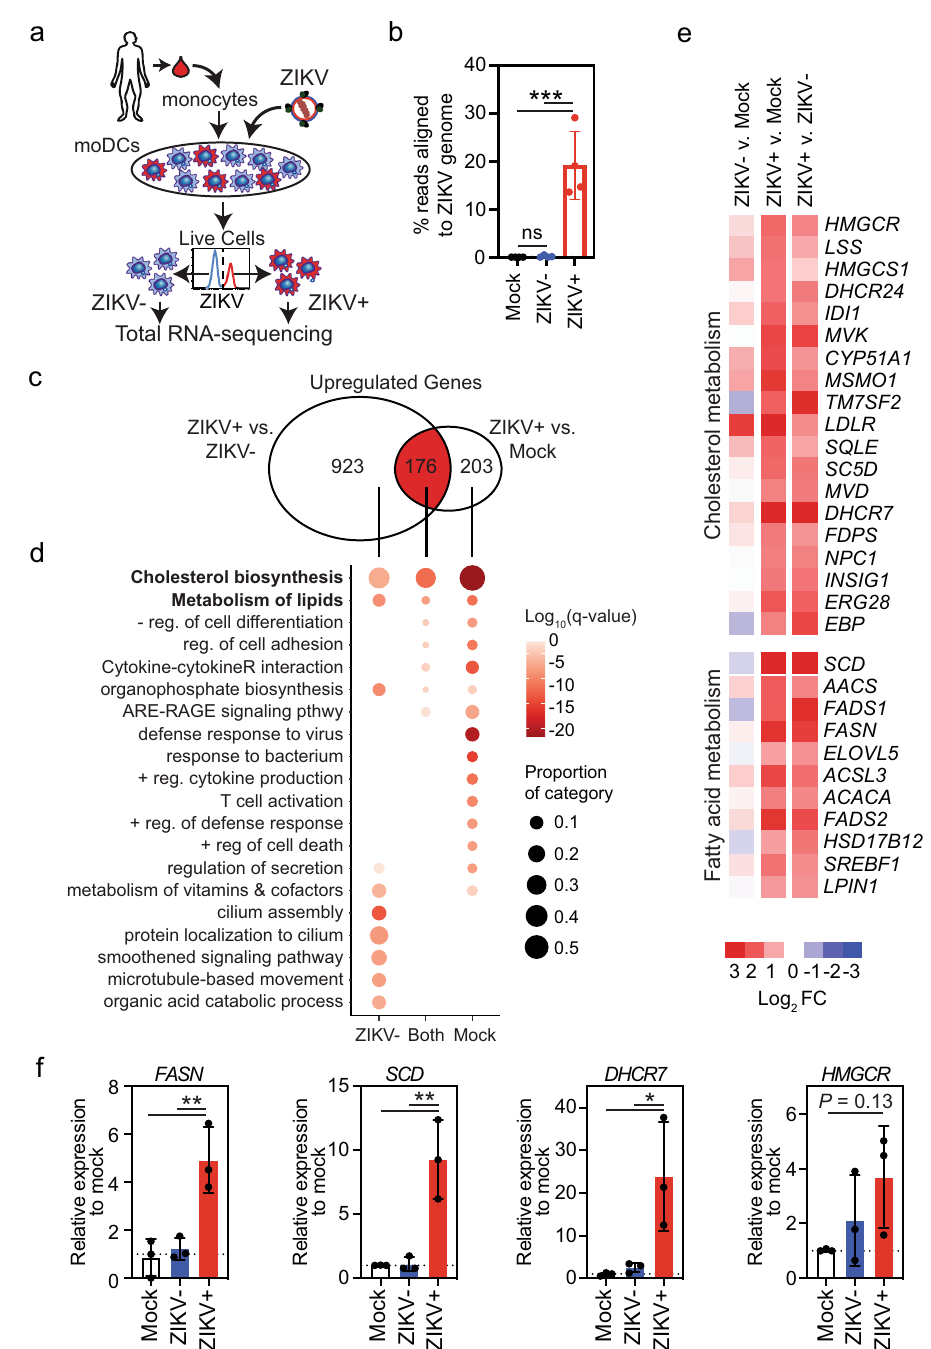
Fig. 1| ZIKV infectionofhumanmoDCsreprogramsexpressionoflipid-related genes. a Human moDCs from four different donors were infected for 24h with ZIKV SD001 at MOI 0.5. Cells were then stained for the viral envelope (E) protein using mAb 4G2 and sorted into ZIKV-infected (ZIKV+) and bystander uninfected (ZIKV − )cells.TotalRNAwasisolatedandsubjectedtoRNA-seq.Mock-infectedcells (Mock)wereanalyzed inparallel. b Percent ofreads aligned to the ZIKVgenome in each cell population. c Venn diagram showing the number of unique and shared genesupregulated(fold-change>2,falsediscoveryrate<0.01)inZIKV+vsZIKV − or